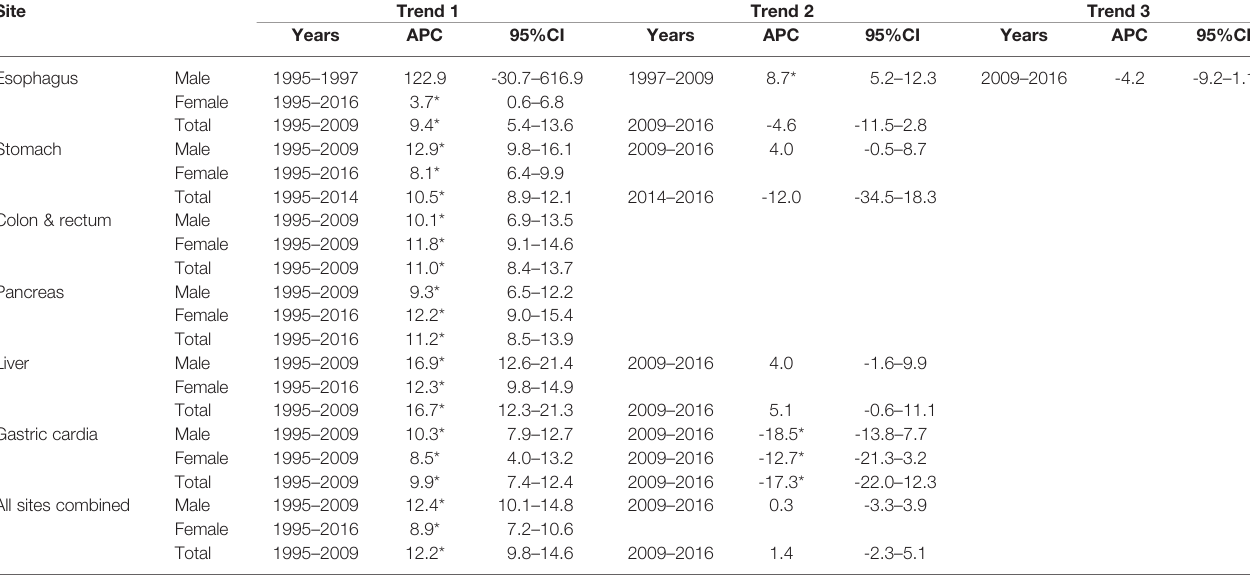
TABLE 3 | Incidence temporal trends (age-standardized to the Segi standard population) for the common GI cancers and all GI neoplasms combined by sex in Wuwei, northwestern China, 1995 – 2016.